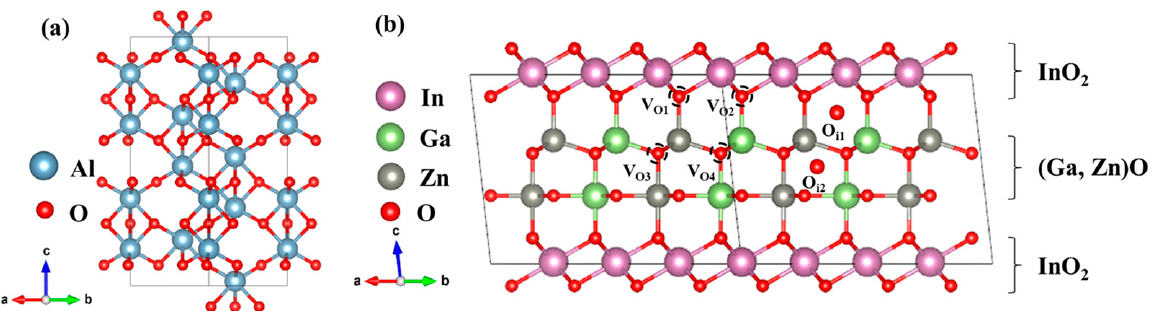
Figure 2. Crystal structure of ( a ) α -Al 2 O 3 and ( b ) CAAC-IGZO. The structural model is drawn with VESTA [36].